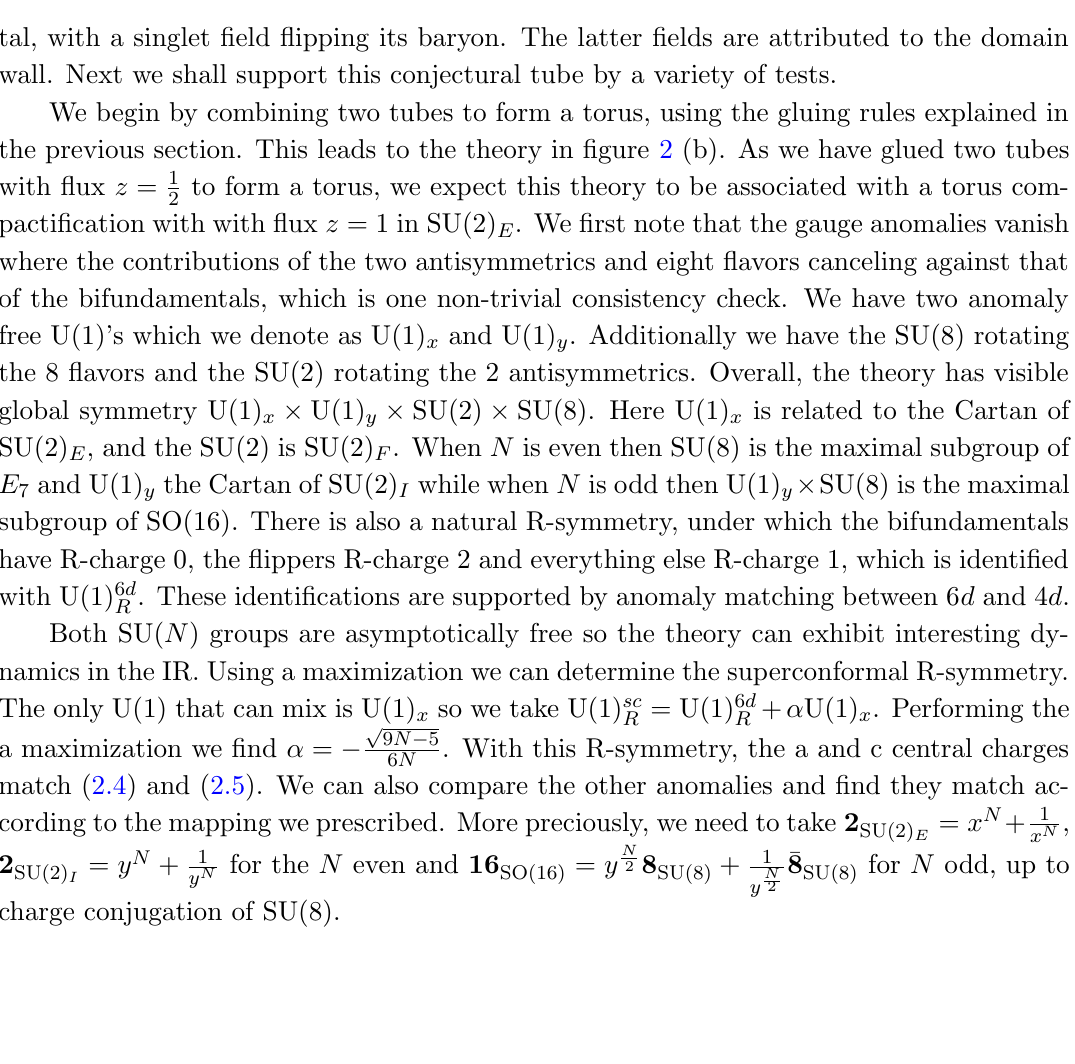
Figure 2 . 4 d theories associated with the compacti(cid:12)cation of the SU(2) (cid:2) E 7 SCFT for N = 2 n and of the SO(16) SCFT when N = 2 n + 1. In (a) the compacti(cid:12)cation surface is a sphere with two maximal punctures, and the (cid:13)ux is z = 1 in SU(2) E . In (b) the compacti(cid:12)cation surface is a 2 torus, and the (cid:13)ux is z = 1 in SU(2) E . The arrows from a group to itself are all antisymmetric or conjugate antisymmetric chiral (cid:12)elds, where the representation is such that they can form a gauge invariant with an antisymmetric combination of the bifundamentals. In both theories there is a cubic superpotential along the triangle and also a quartic one connecting the antisymmetrics on the two sides via two